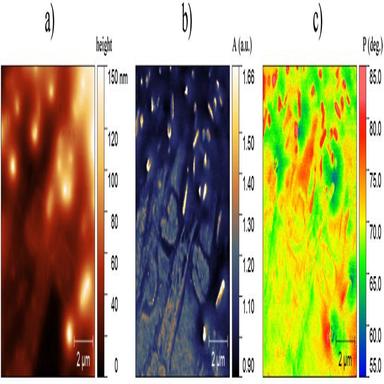
Zebrafish retina sample; (a) AFM topography; (b) s-SNOM 3rd harmonic amplitude; (c) s-SNOM 3rd harmonic phase.